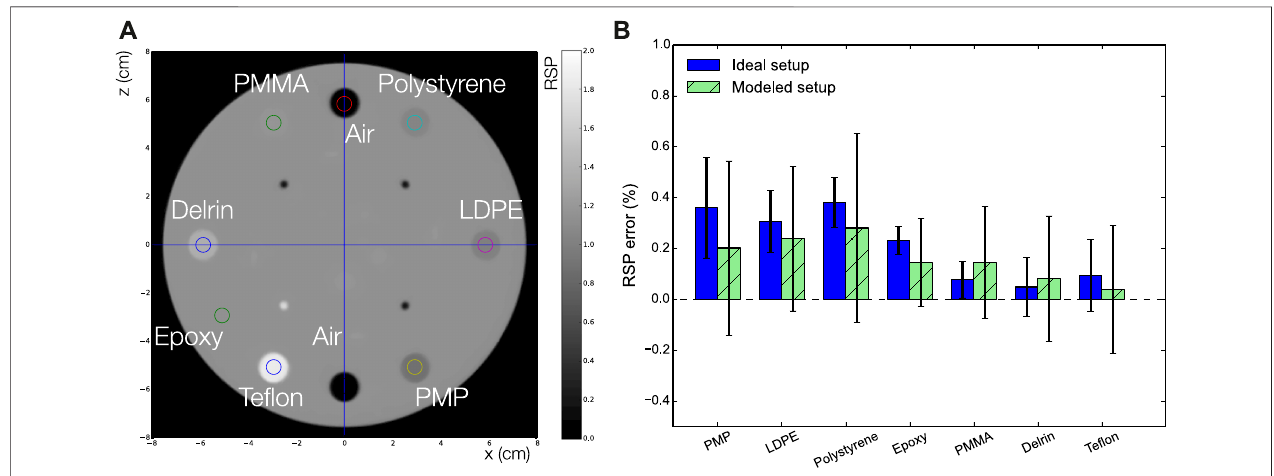
Frontiers in Physics |